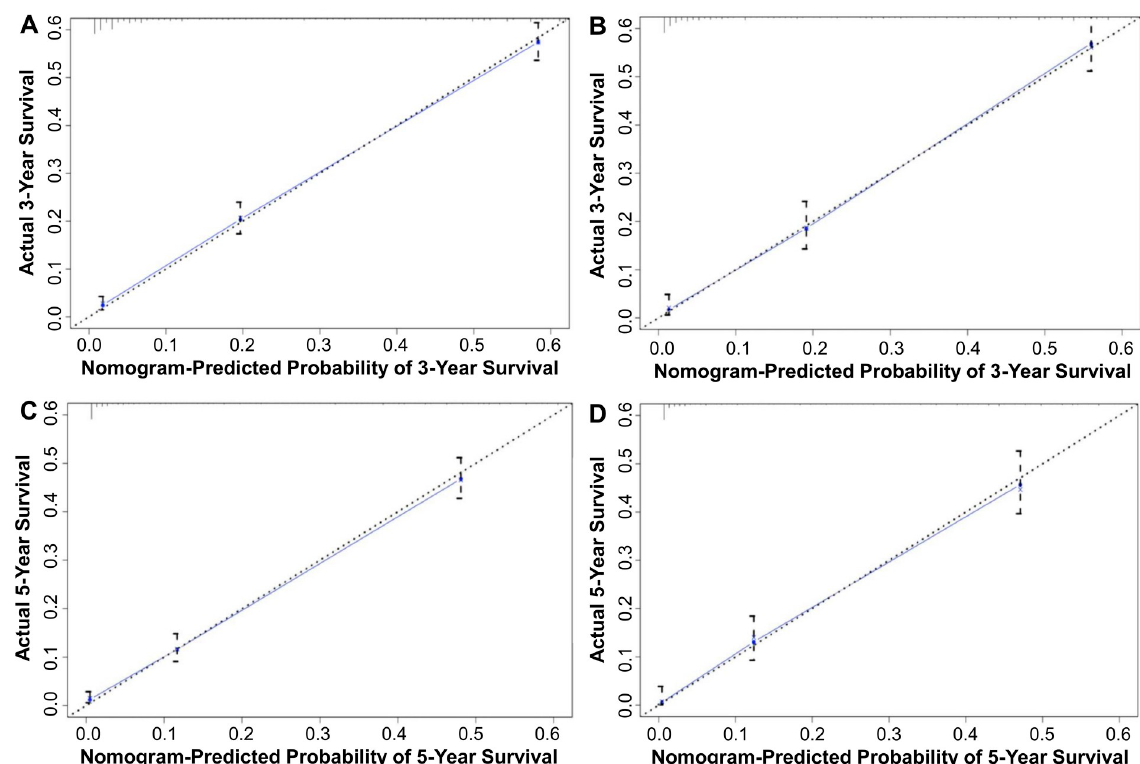
Fig 2. Calibration curves of the nomogram for predicting 3-year OS in the (A) training set and (B) validation set, and predicting 5-year OS in the (C) training set and (D) validation set. Nomogram-predicted OS is plotted on the x -axis and the actual OS is plotted on the y -axis. The diagonal dotted line indicates the ideal nomogram, in which the actual and predicted probabilities are identical. The solid line indicates the actual nomogram, of which a closer fit to the dotted line indicates a better calibration.